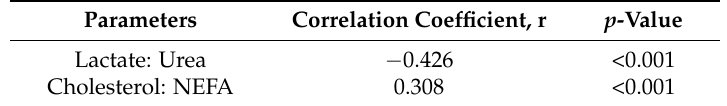
Table 6. Relationship between blood parameters of pigs fed control and transglycosylated starch diets. Parameters Correlation Coefficient, r p -Value Lactate: Urea − 0.426 <0.001 Cholesterol: NEFA 0.308 <0.001 NEFA, non-esterified fatty acids: All other correlations were not significant.